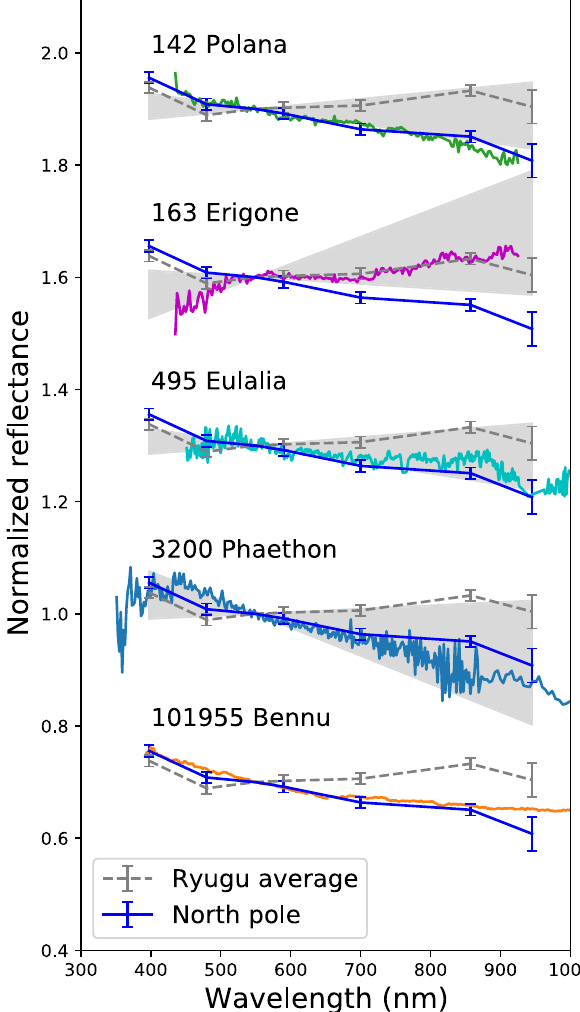
Fig. 7 Least processed region on Ryugu compared with spectrally blue asteroids. Spectral comparison of the north polar region (solid blue line) with the possible parent bodies, (142) Polana, (163) Erigone, and (495) Eulalia, the B-type near-Earth asteroid (3200) Phaethon and (101955) Bennu. Spectra are normalized at 0.55 µ m and offset by 0.3. Re fl ectance spectra of (142) Polana, (163) Erigone, (495) Eulalia, (3200) Phaethon, and (101955) Bennu were obtained by refs. 25,68,69 , and ref. 32 , respectively. Gray hatches for (142) Polana, (163) Erigone, and (495) Eulalia indicate 80% of the distribution of slope among their family members 29,70 . Gray hatch for Phaethon indicates spectral variation over one rotation 31